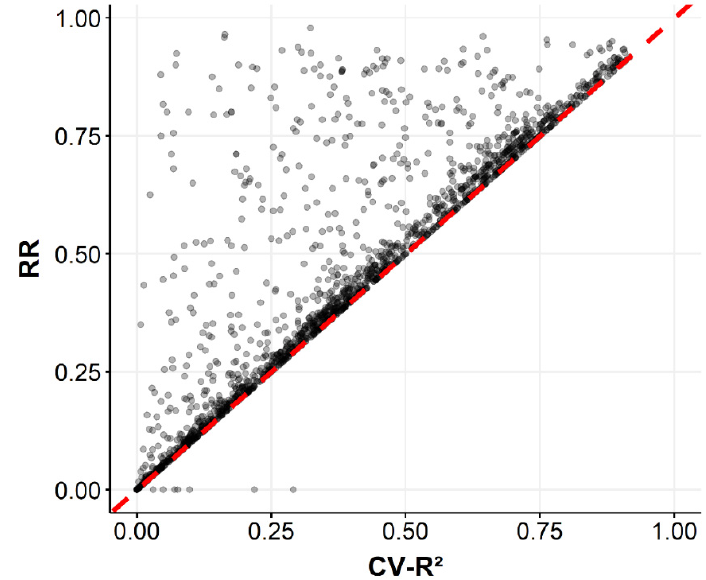
Figure 6. Relationship between CV-R 2 and RR for the entire sample set. The red dashed line indicates the 1:1 line between these two metrics. RR and CV-R 2 were positively correlated and CV-R 2 performance appeared to indicate a minimum RR value. Models that appear above the 1:1 line in this graph are those whose R 2 score decreased less than would be expected given the dominant trend of RR usually being equal to CV-R 2 . For example, a model with a CV-R 2 of 0.5 and an RR of 0.75 indicates that the R 2 only declined by 25% from training goodness-of-fit to CV, which suggests less overfitting than most models with a CV-R 2 of 0.5 that usually had a decline from training goodness-of-fit of 50%.